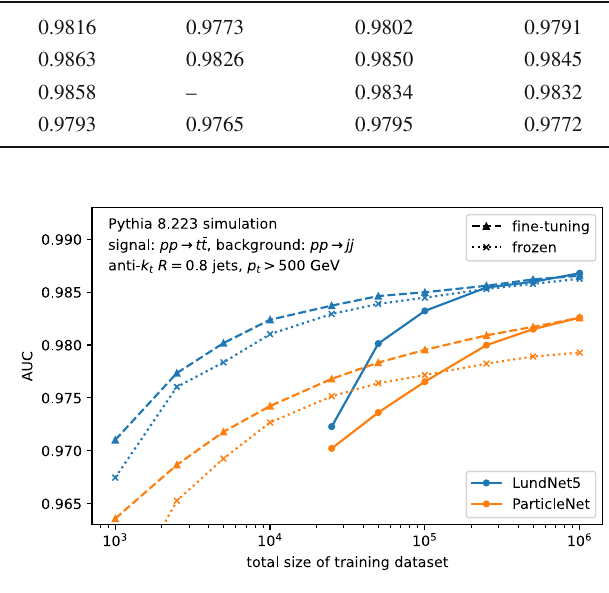
Fig. 4 Area under the ROC curve as a function of the total signal and background training data set